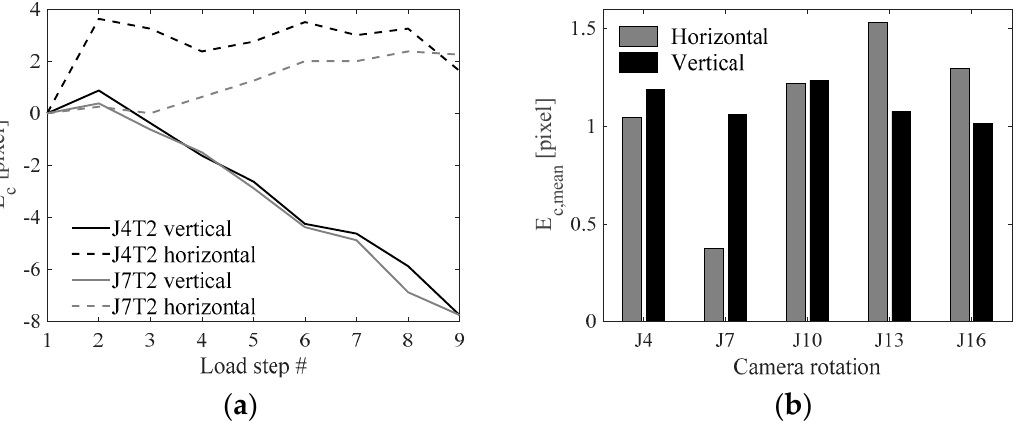
Figure 8. RCS rotation error. ( a ) Vertical and horizontal at J7T2. ( b ) Mean vertical and horizontal camera rotation errors for five rotations of the camera (see Table 1).